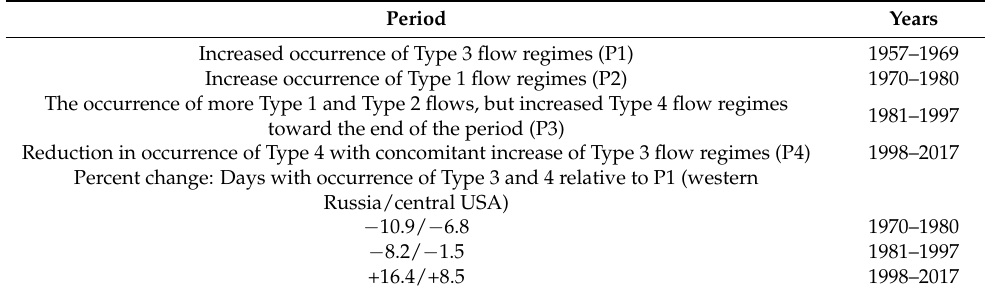
Table 1. Circulation periods within the 1957–2017 epoch according to references [4,7]. Also, the percent change in zonal versus meridional flow regimes for western Russian and central USA regions are shown. Negative indicates an increase in the percentage of zonal flow